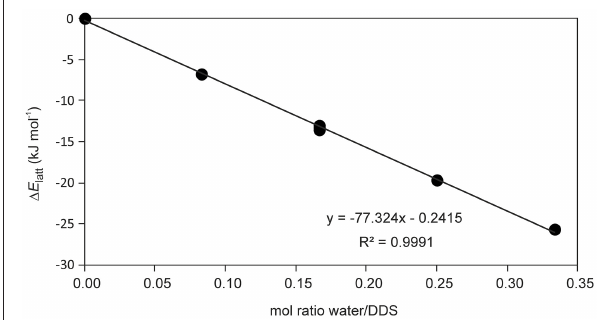
FIGURE 5 | Photomicrographs of DDS 0.33-Hy . Dehydration in the temperature range 40 ◦ -100 ◦ C, Hy dehy to form II transformation in the temperature range 110 ◦ -114 ◦ C, and peritectic dissociation (crystals embedded in high-viscosity silicon oil) of 0.33-Hy to form II in the temperature range 115 ◦ − 132 ◦ C.